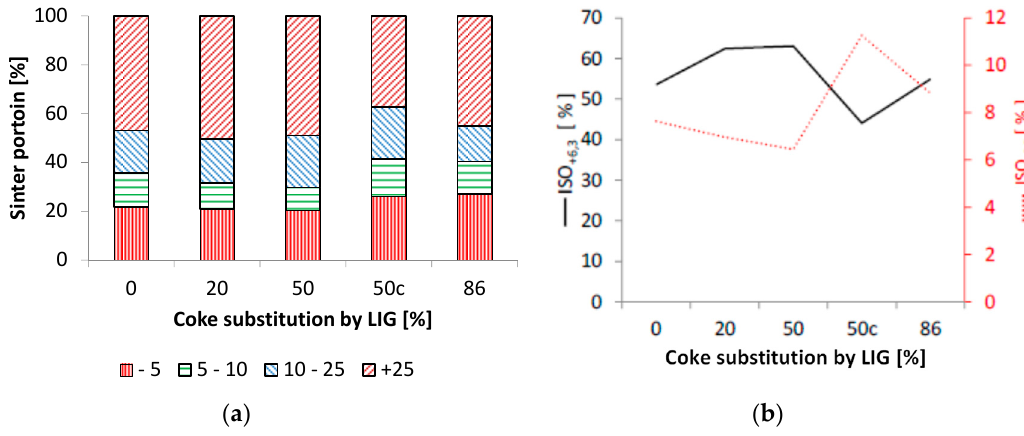
Figure 14. The impact of coke substitution on the granulometric ( a ) and strength parameters ( b ) of the agglomerates.